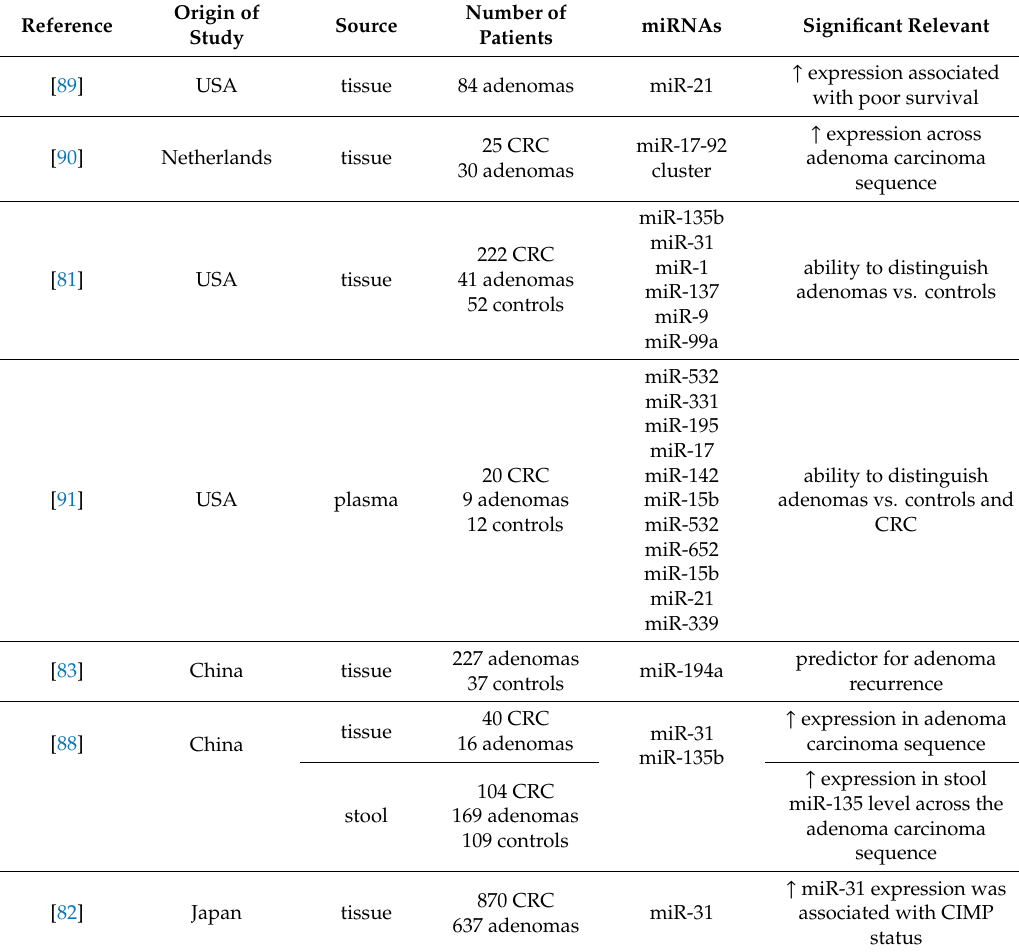
Table 3. Summary of studies focusing on miRNA profiles in colorectal cancer (CRC) adenomas (in chronological